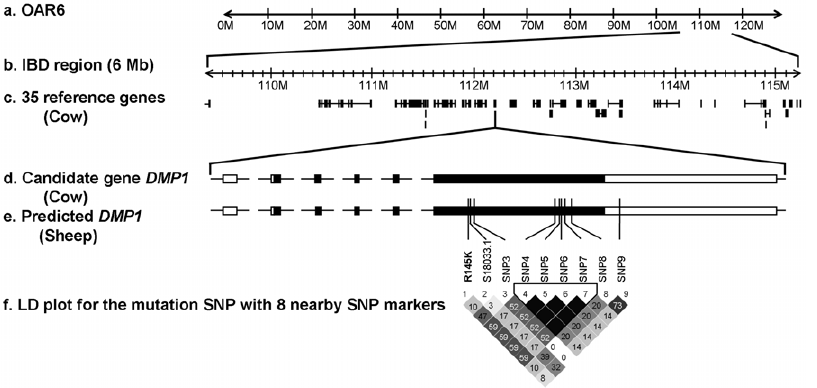
Figure 2. Work flow chart for discovering the mutation locus of inherited rickets in Corriedale sheep. ( a ) The sheep chromosome 6 (OAR 6). ( b ) The IBD region containing the causative locus is located on OAR 6 between 109 and 115 Mb. ( c ) The black boxes show 35 cow reference genes encompassing the sheep IBD region based on the comparative genomic maps. ( d ) & ( e ) The boxes represent exons of the cow and the predicted sheep DMP1 genes. The solid parts of boxes demonstrate the coding region for DMP1 . The vertical lines on exon 6 are representing the mutant SNP (R145X) with the other 8 SNPs. ( f ) The number and color in each diamond box shows r 2 value for each pair of SNPs. Higher numbers and darker colors indicate SNPs are with higher LD. Four SNPs in block 1 show a complete mutual linkage disequilibrium (LD) but not with the causative